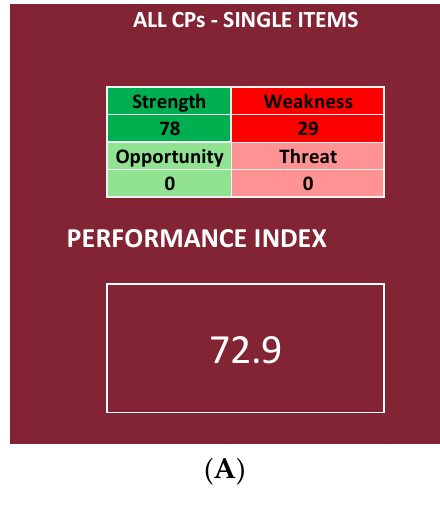
Figure 9. Performance index calculated by using the scores of all four CPs but inserting either the single items ( A ) or only the Questionnaire Sections mean scores ( B